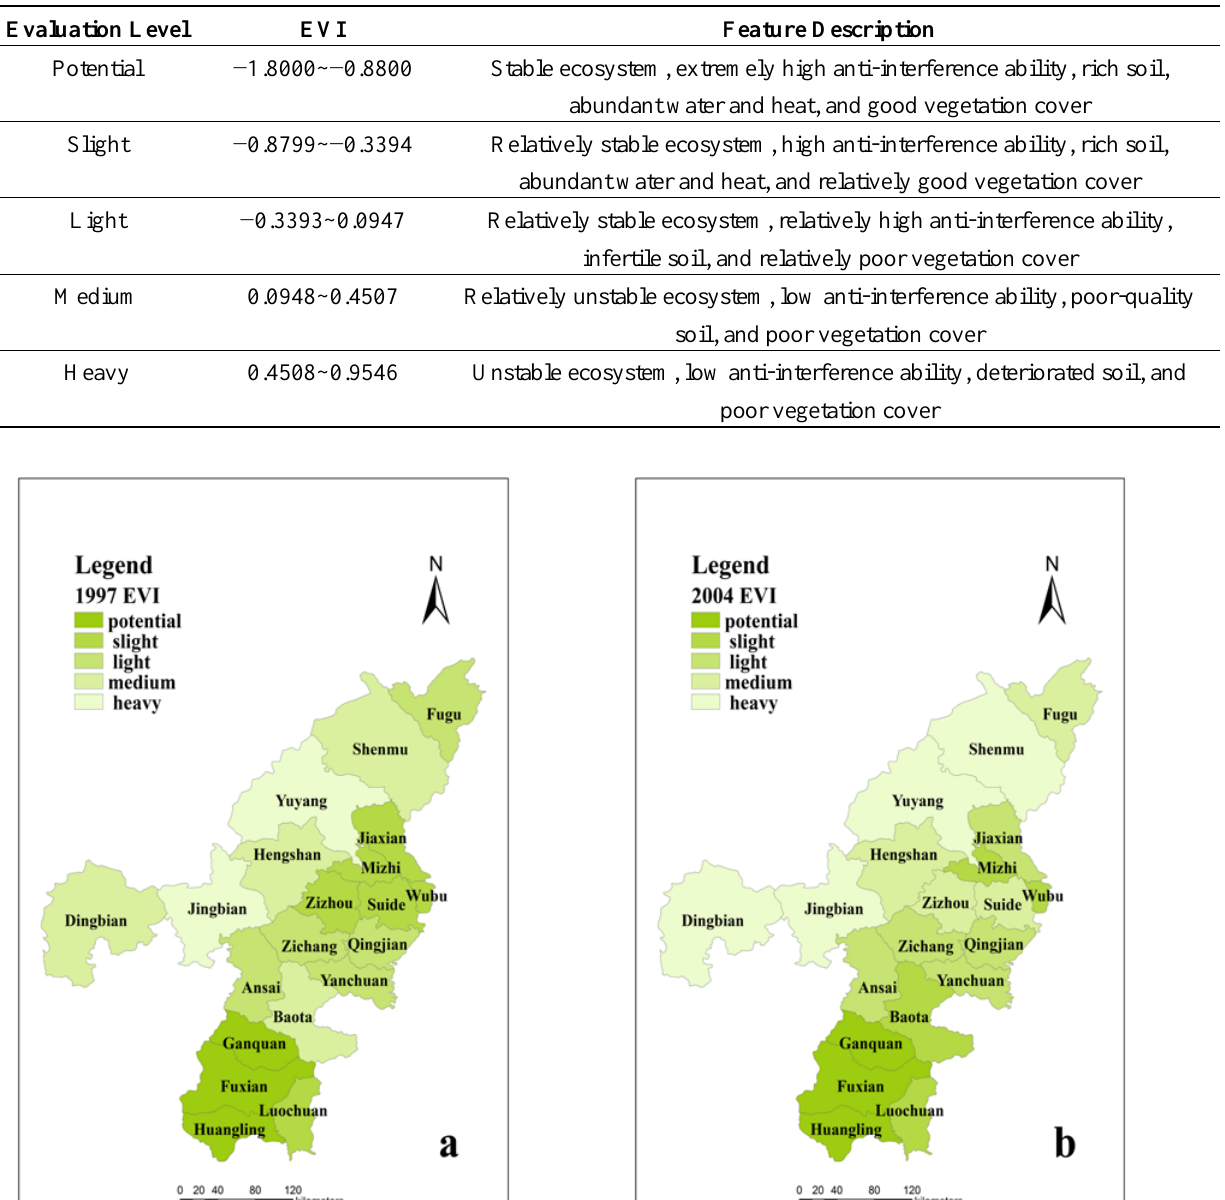
Table 2. Classification of ecological vulnerability in Northern